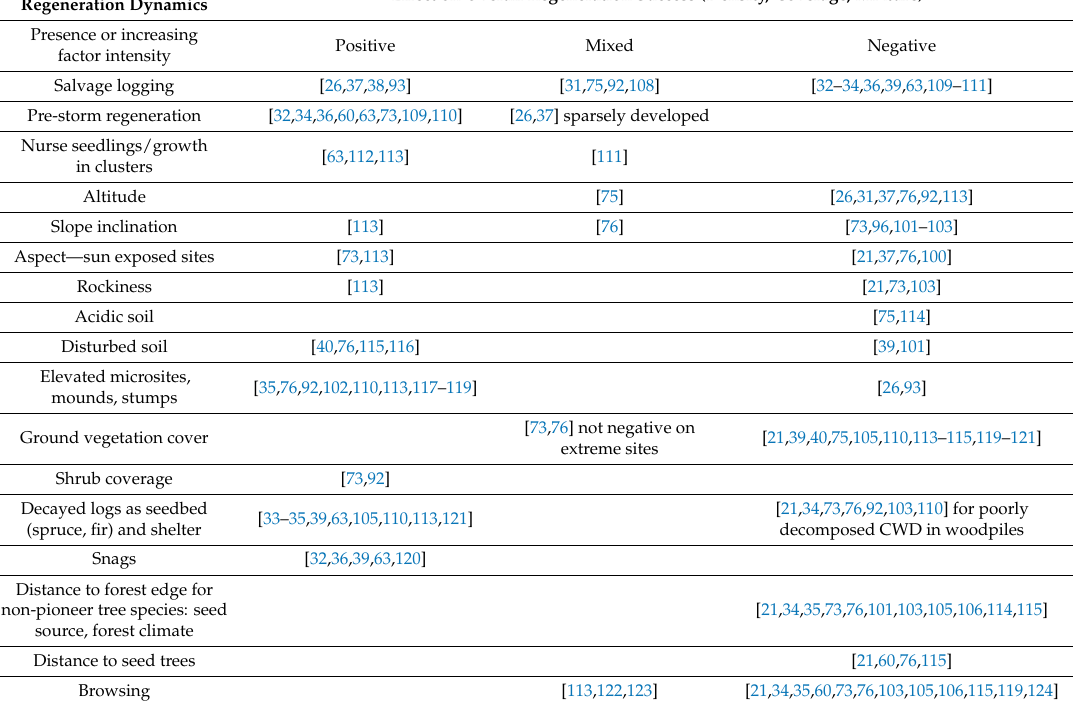
Table 1. Synthesis table showing the relationship between driving factors and post-disturbance regeneration success from published literature. The table covers mostly temperate European mountains, with a focus on beech, mixed mountain, and spruce forests, with some comparable studies from North and Eastern Europe. The most frequent species in the regeneration layer was spruce. Mixed denotes that a given factor was tested, but its effects were either non-consistent or non-significant. Drivers of Post-Disturbance Effect on Overall Regeneration Success (Density, Coverage, Regeneration Dynamics